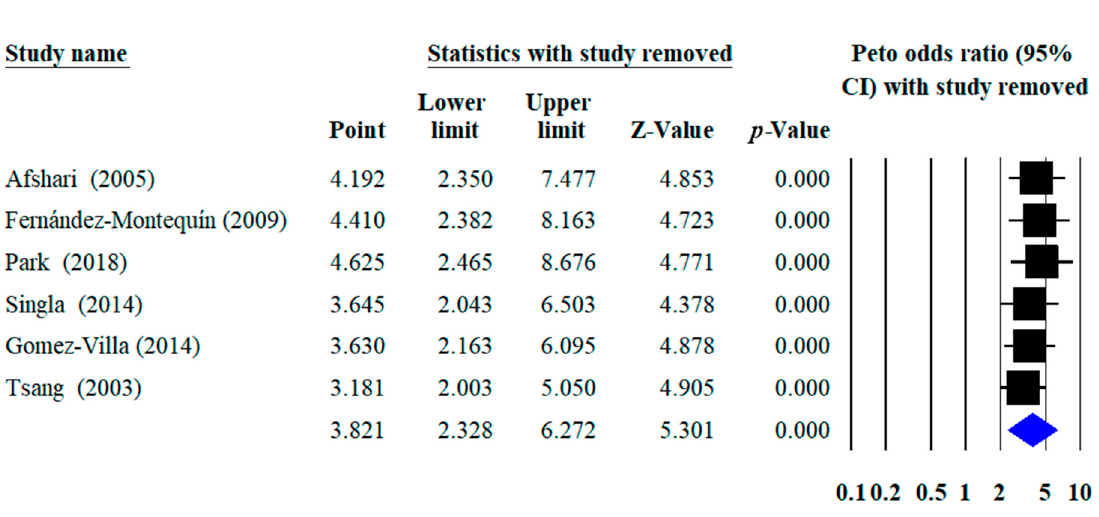
Figure 6. Funnel plot and Egger’s regression test on determining publication bias.